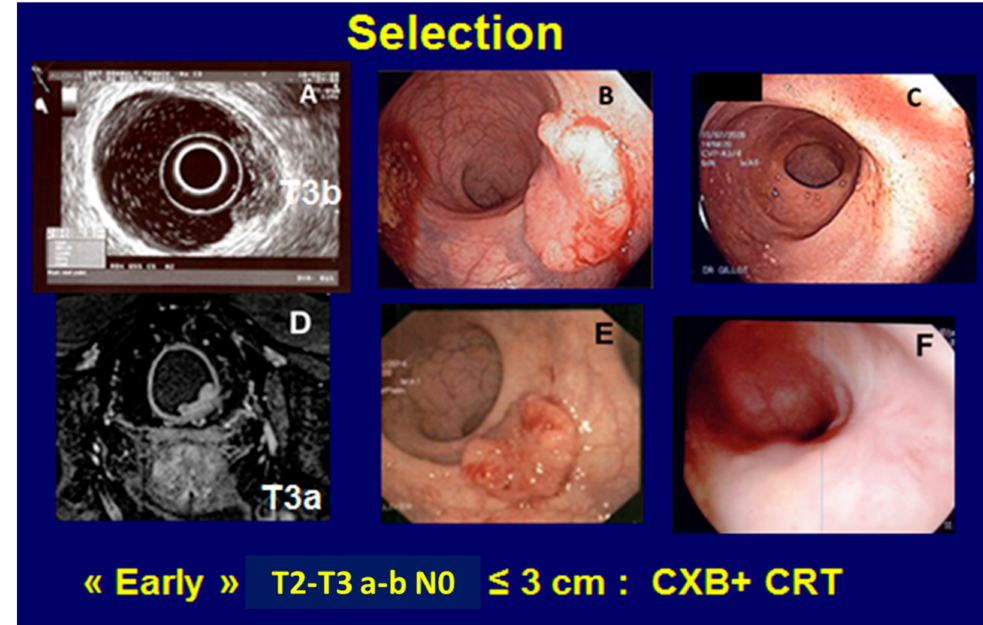
Figure 3. Example of T3 rectal adenocarcinoma suitable for organ preservation and treated using CXB 50. The tumor was 3 cm or less, <1/3 rectal circumference ( A – D ), partly exophytic with moderate central ulceration ( B – E ) and could easily be incorporated into the rectal applicator of 3 cm diameter (low-middle rectum), especially if located in the anterior or lateral part of the rectum (when the patient is in the knee–chest position). Normal rectal wall one year after treatment ( C – F